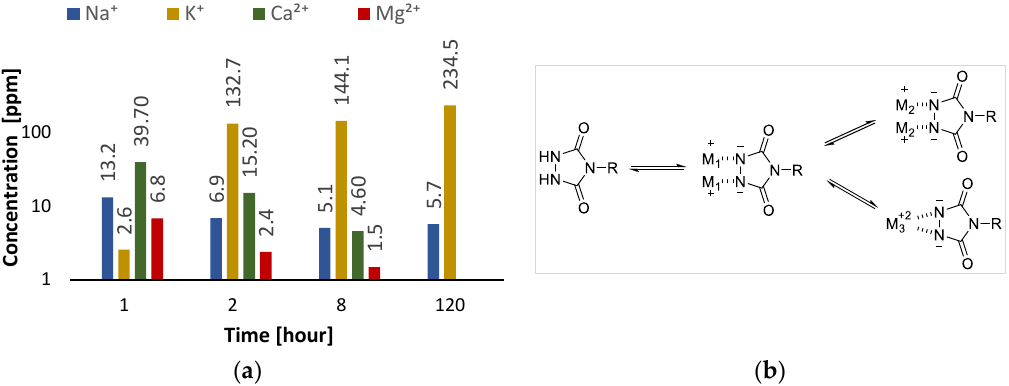
Figure 8. ( a ) Ion-chromatography analysis of tap water treated with urazole-potassium gel for 2, 8, and 120 h. ( b ) Possible ion-exchange mechanism of the urazole group.